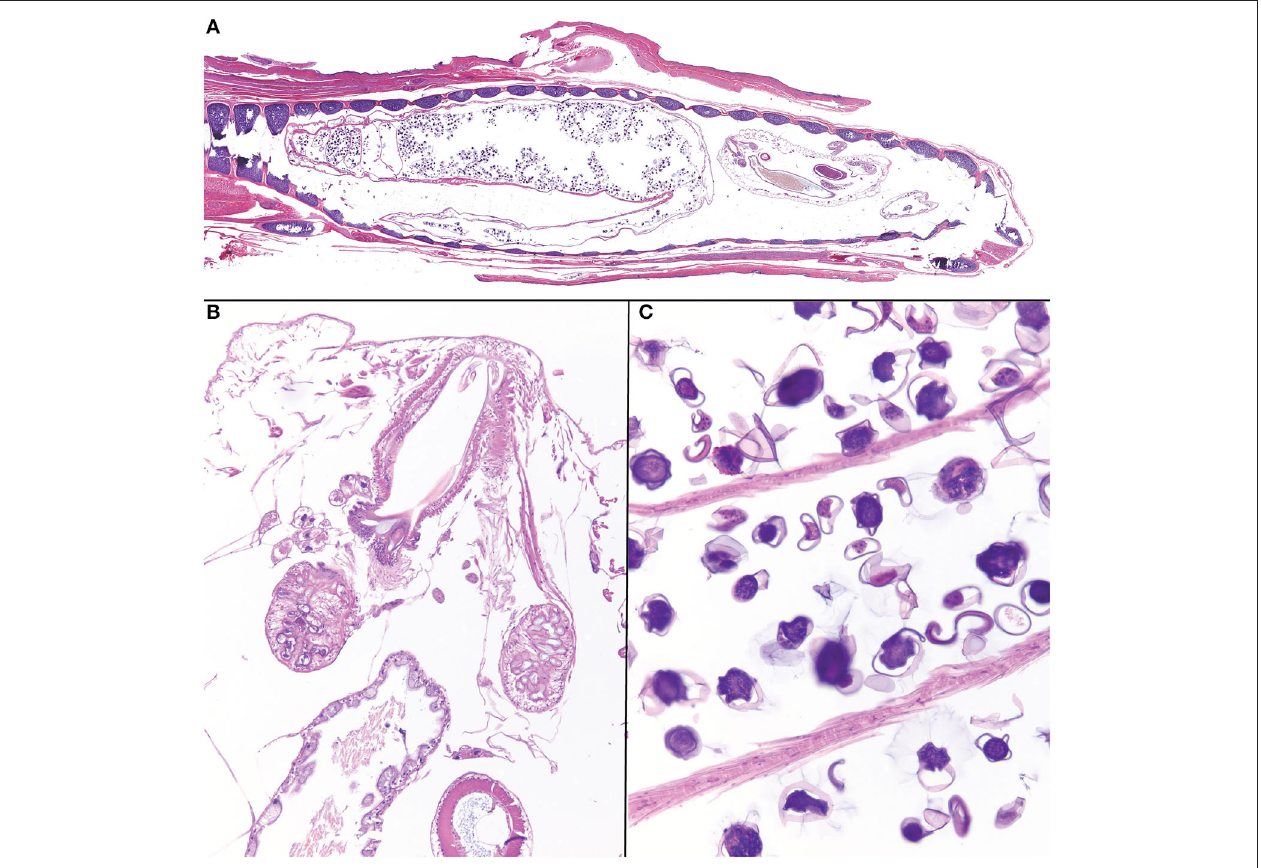
FIGURE 2 | Photomicrographs of Raillietiella orientalis pentastomes within the trachea of a banded water snake ( Nerodia fasciata ). (A) On subgross examination, cross and longitudinal male and female parasites fill the lumen of the trachea. (B) The buccal cadre of a male parasite with hooks and acidophilic glands. (C) Ova within the lumen of a female Raillietiella orientalis .